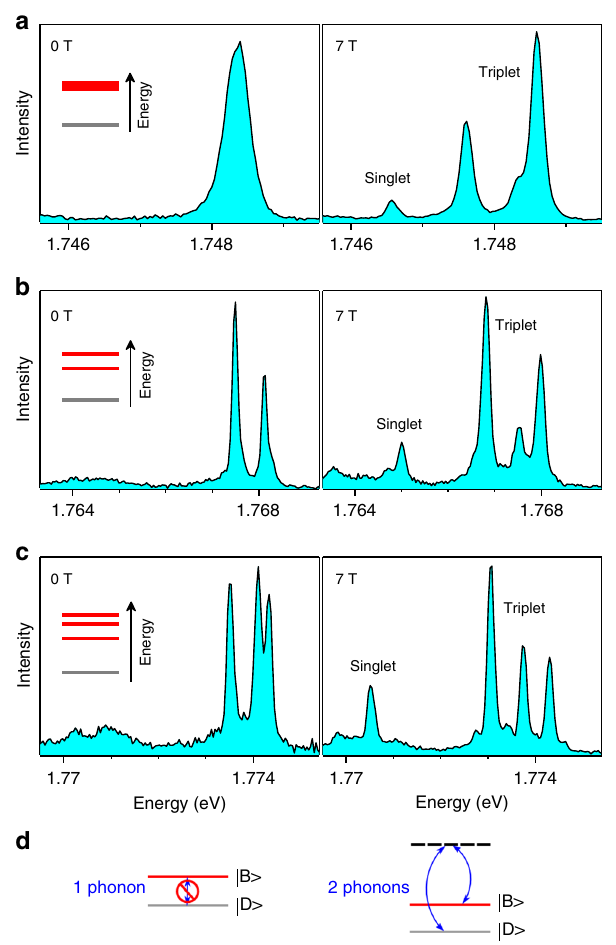
Fig. 2 Magnetic brightening of the ground dark singlet exciton of single CsPbI 3 NCs. a – c Spectra of three different single NCs at 4 K, which present one a , two b , three c exciton recombination ZPLs in zero fi eld. The insets show the corresponding diagrams of exciton fi ne structure, which are sensitive to shape anisotropy. The levels displayed in red represent the optically active triplet states, while the ground level in gray is the singlet dark state. At 7 T, magnetic splitting and coupling among the fi ne structure sublevels reveal the entire spectral fi ngerprint of the bright triplet and the lowest-energy singlet state. d Bright-to-dark relaxation with a one-phonon process is inhibited in lead halide perovskites (left panel). Thermal mixing between dark and bright states occurs via a two-phonon process (right